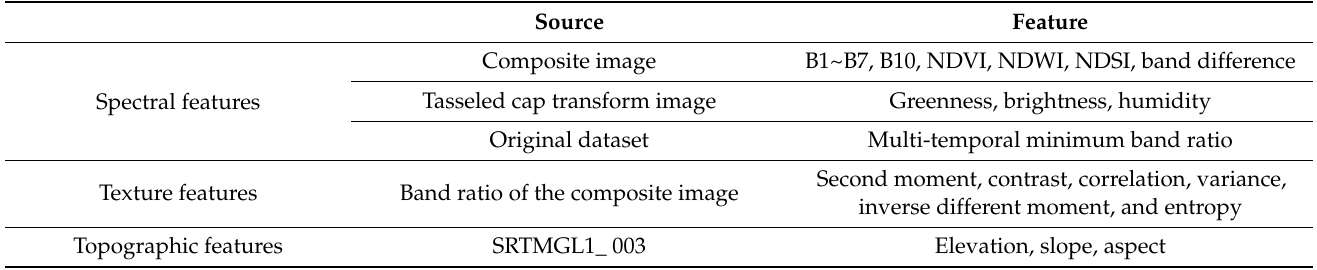
Table 2. Feature